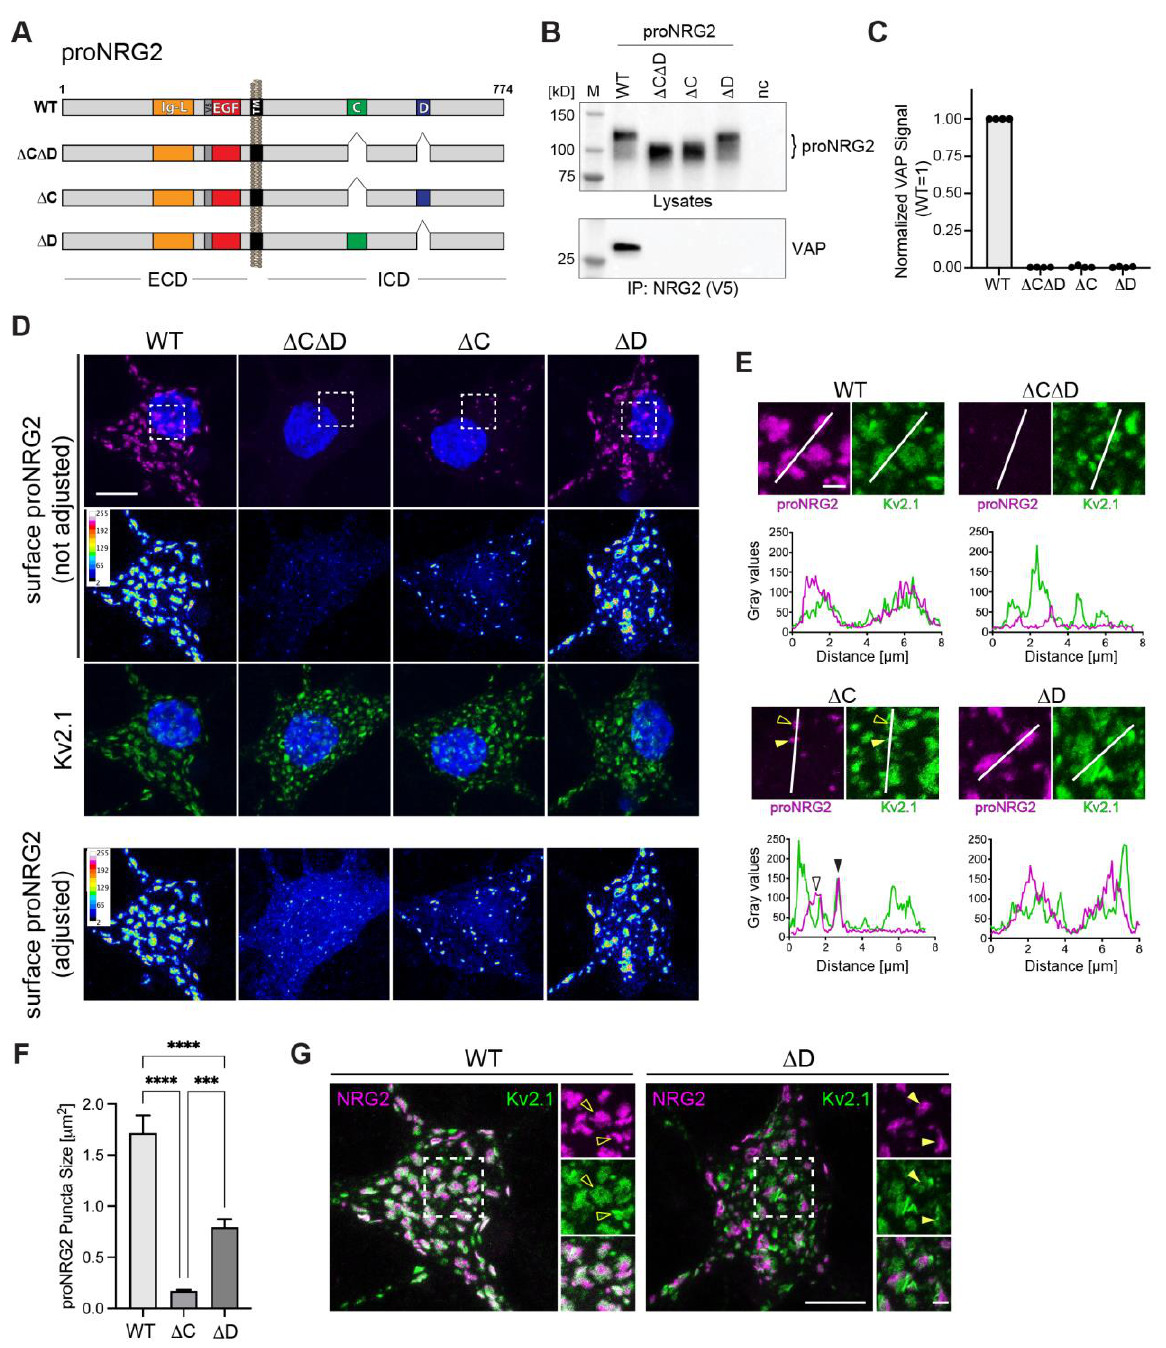
Figure 4. Role of C- and D-boxes in proNRG2/VAP interactions. ( A ), Schematic illustration of proNRG2 and C/D-box deletions constructs. Locations of C- and D-boxes in the ICD, EGF-like (EGF) and Ig-like (Ig-L) domains in the ECD, transmembrane domain (TM), and V5 epitope tag used for IP are shown. ( B ), Representative Western blot confirming comparable expression levels of proNRG2 constructs in neuron lysates (top) and showing corresponding VAP co-immunoprecipitation results (bottom). nc , untransduced control. ( C ), Densitometric quantification of VAP co-im- munoprecipitation band intensities; note that only WT proNRG2 co-immunoprecipitates VAP. Data are normalized to VAP co-immunoprecipitation signals obtained with WT proNRG2 ( n = four inde- pendent experiments). ( D ), Confocal micrographs of surface-labeled proNRG2 showing differences